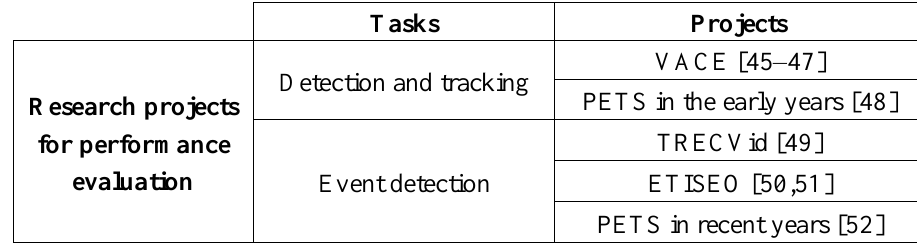
Table 3. Past research projects on performance